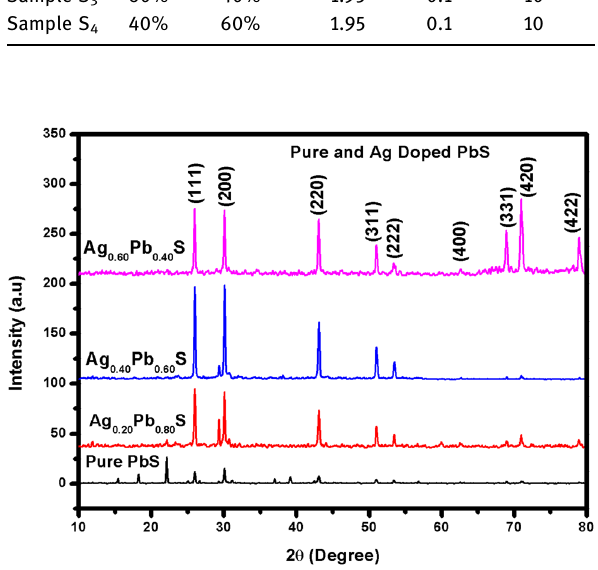
Figure 2: XRD pattern of pure PbS and Ag:PbS at di ff erent concen - trations: ( a ) 20%, ( b ) 40%, and ( c )